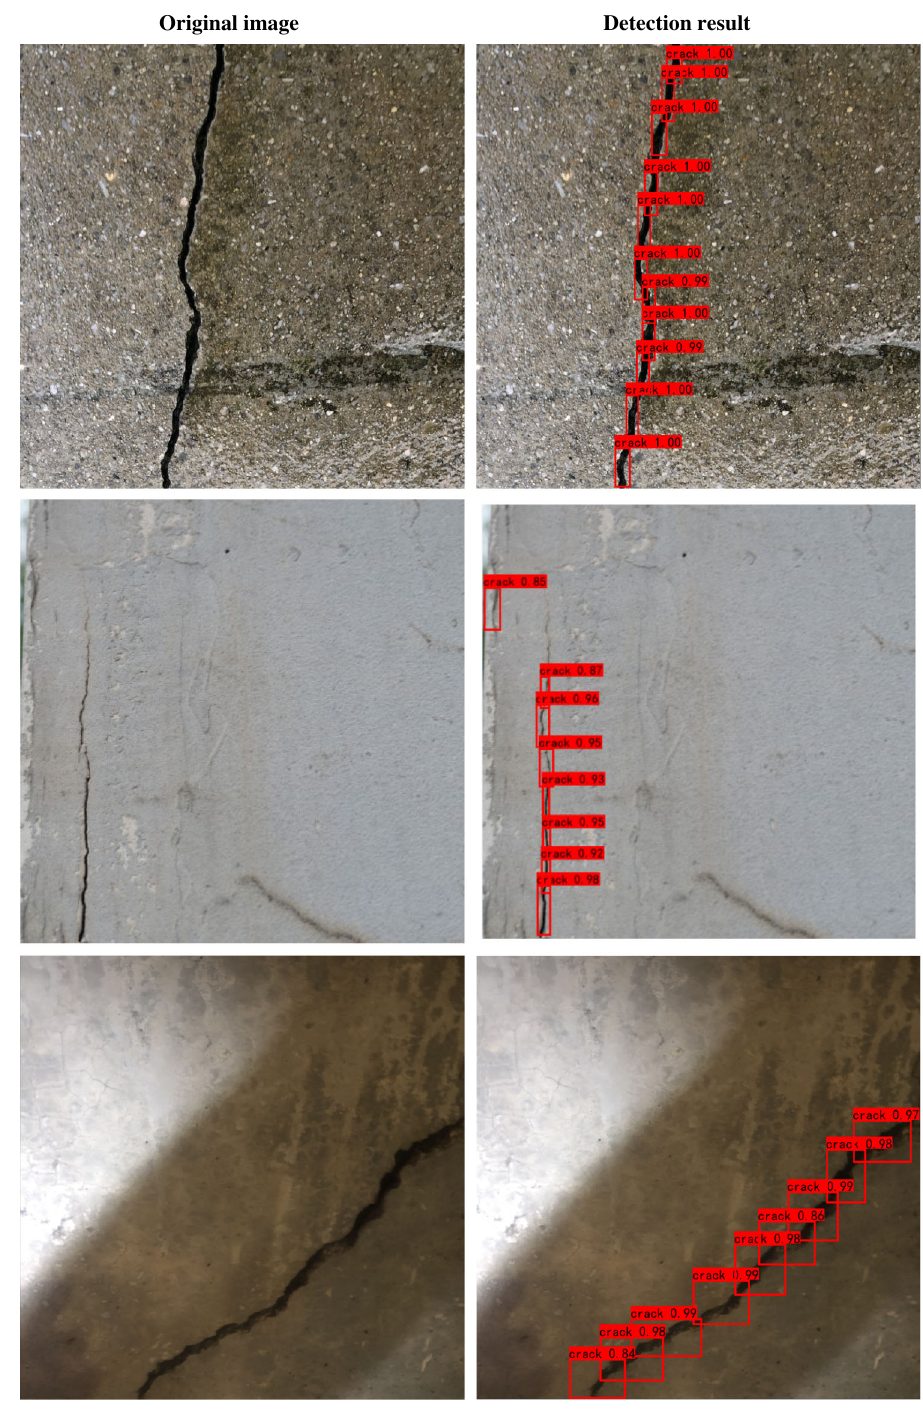
Fig. 10 Image test results of bridge surface crack